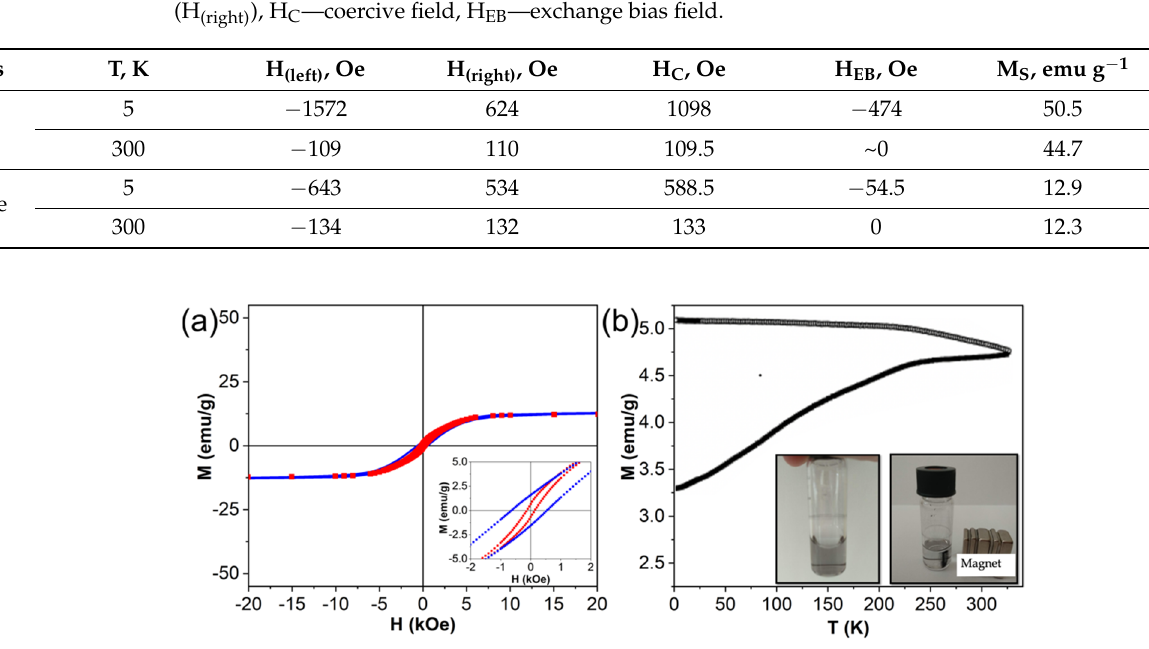
Table 1. Magnetization values of Fe oxide NPs and core-satellite Au-Fe NPs at 5 K and 300 K. M S — magnetization saturation, H (left) —intersections on the field axis at increasing and decreasing fields (H (right) ), H C —coercive field, H EB —exchange bias field.